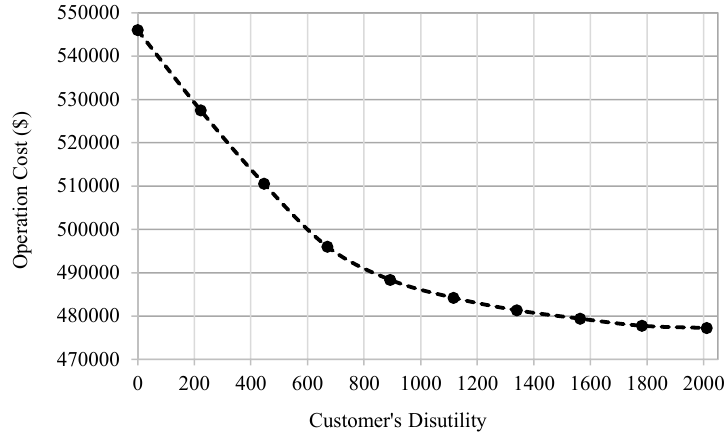
Figure 4. The obtained Pareto front.